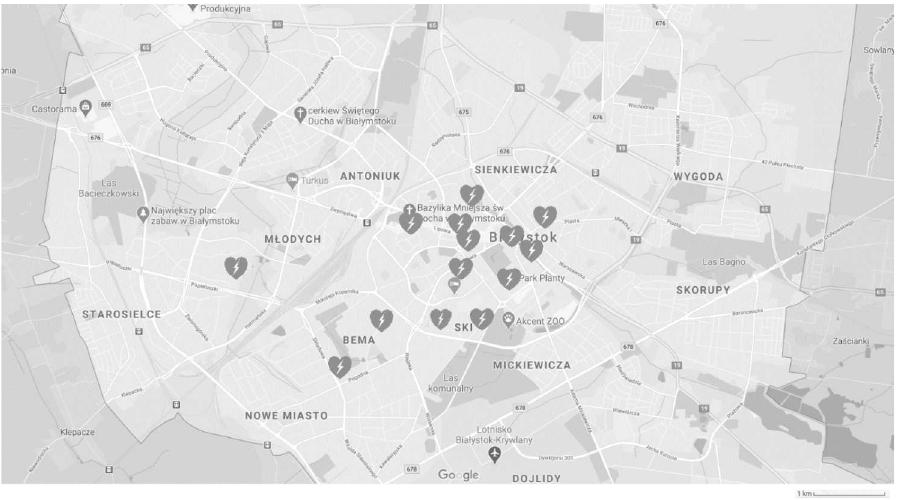
Figure 1. The current deployment of urban AED devices in Białystok